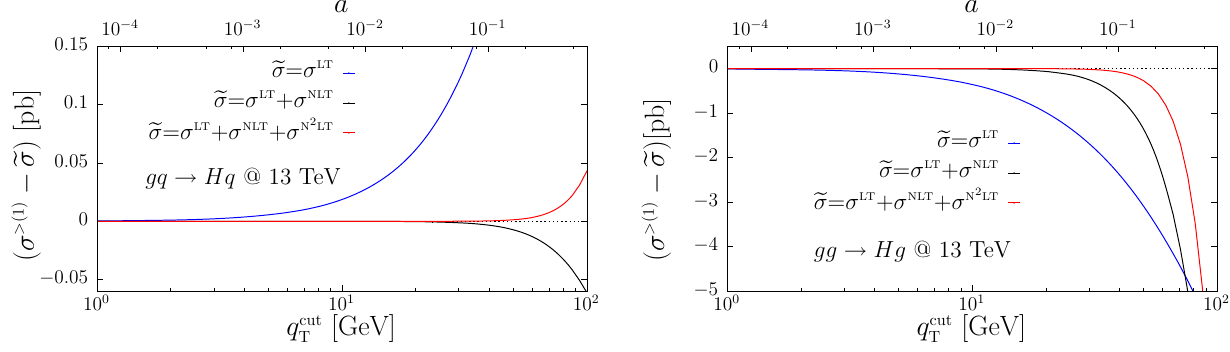
(cid:9) (cid:10) σ >( 1 ) − ! σ as a function of q cut